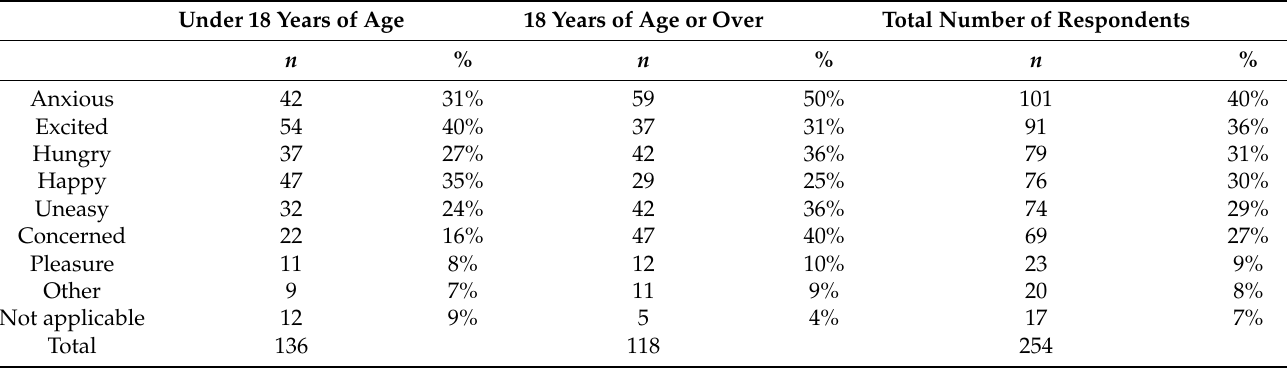
Table 7. Emotions of adults with PKU/caregivers of children before dining out (n = 254) from multiple response